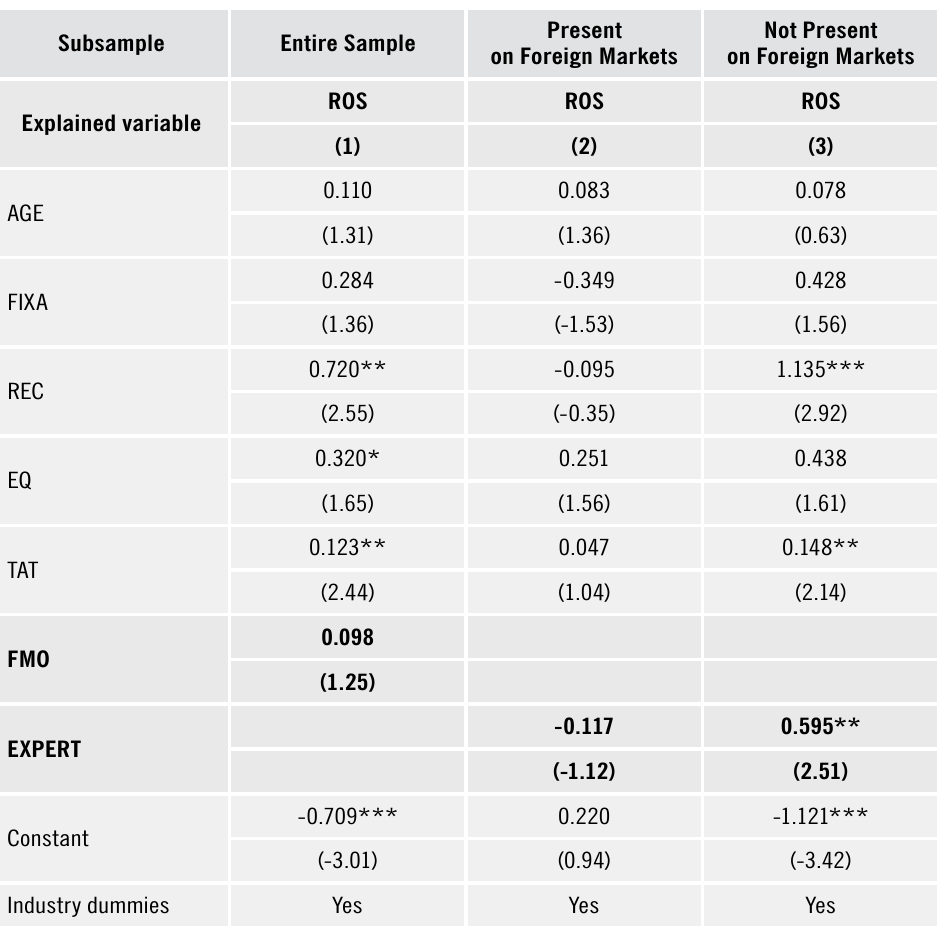
Table 8. Empirical relationship between international expert share and firm contemporaneous